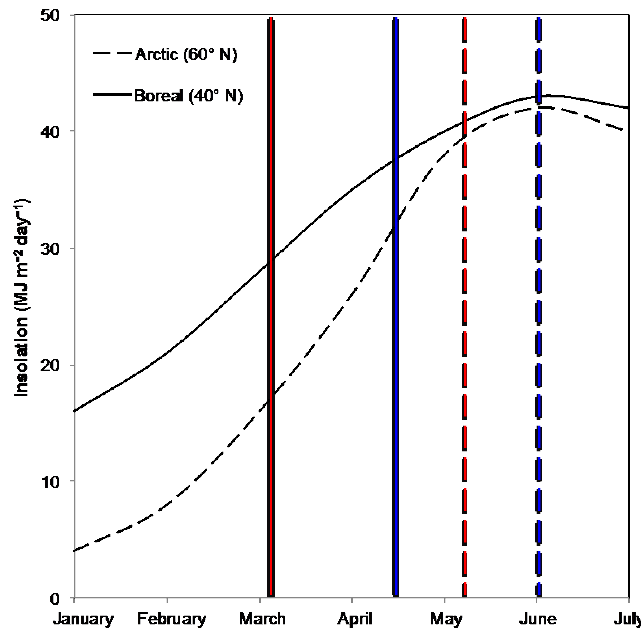
Figure 9. Change in daily solar insolation from January through July for 60° N (representative of the Arctic region) and 40° N (representative of the boreal region). Vertical dashed lines indicate early (red) and late (blue) ice-out dates for the Arctic region and vertical solid lines indicate early (red) and late (blue) ice-out dates for the boreal region. Late ice-out is averaged between the 2013 and 2015 ice-out years. Data are plotted from Buffo et al. [54].